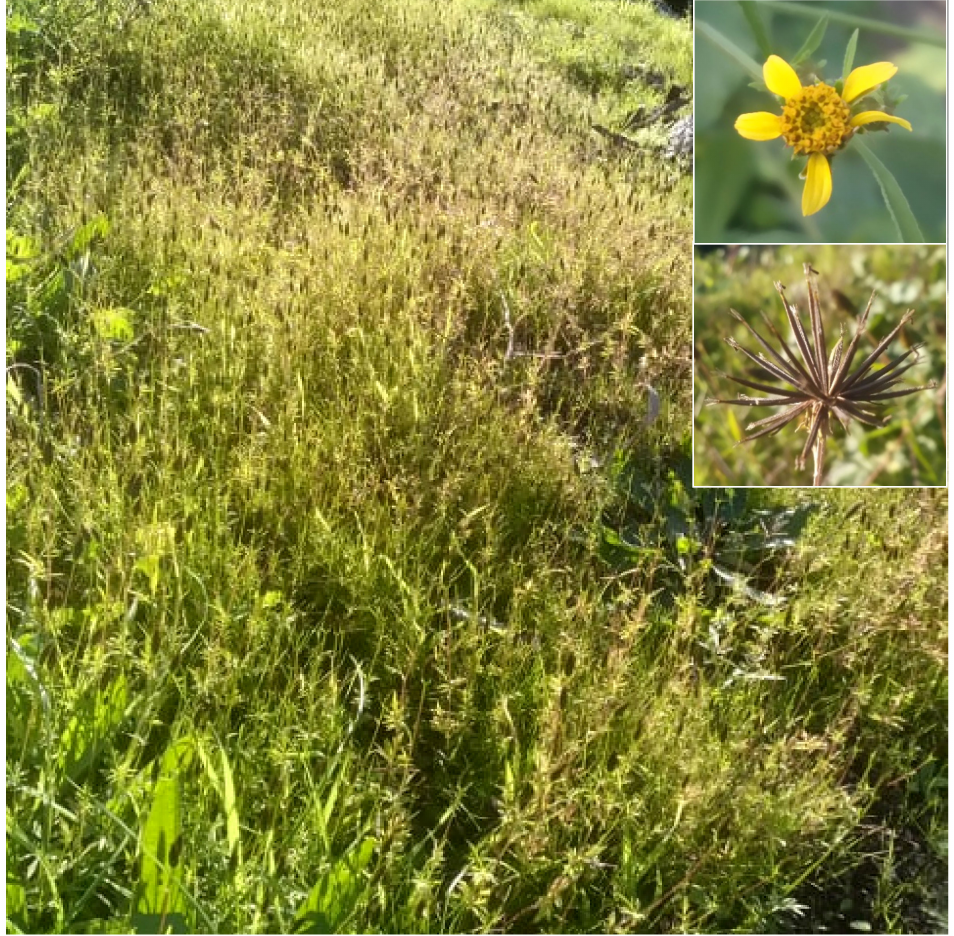
Figure 58. Bidens subalternans in Acquedotti